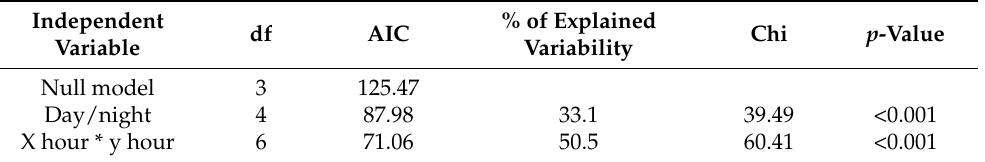
Figure 5. Distribution of recorded bird and mammalian predators at nests during the day ( n = 107 events). Table 5. The effect of day/night and transformed time (interaction between x - hour and y - hour) on presence of bird and mammalian predators at the nests. GLMM analyses, n = 107 events. AIC stands for Akaike information